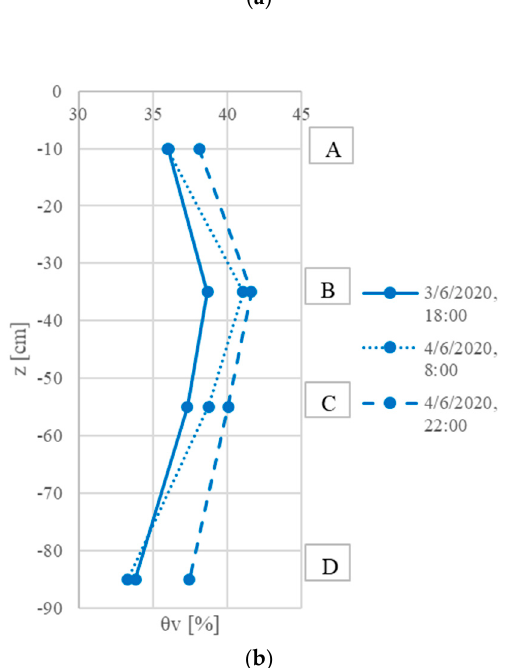
Figure 21. ( a ) 3rd and 4 June 2020 rainfall events and soil water contents; ( b ) Vertical soil moisture profiles for the 3–4 June 2020 rainfall events. Table 8 . Characteristics of the 13 June 2020 rainfall event.